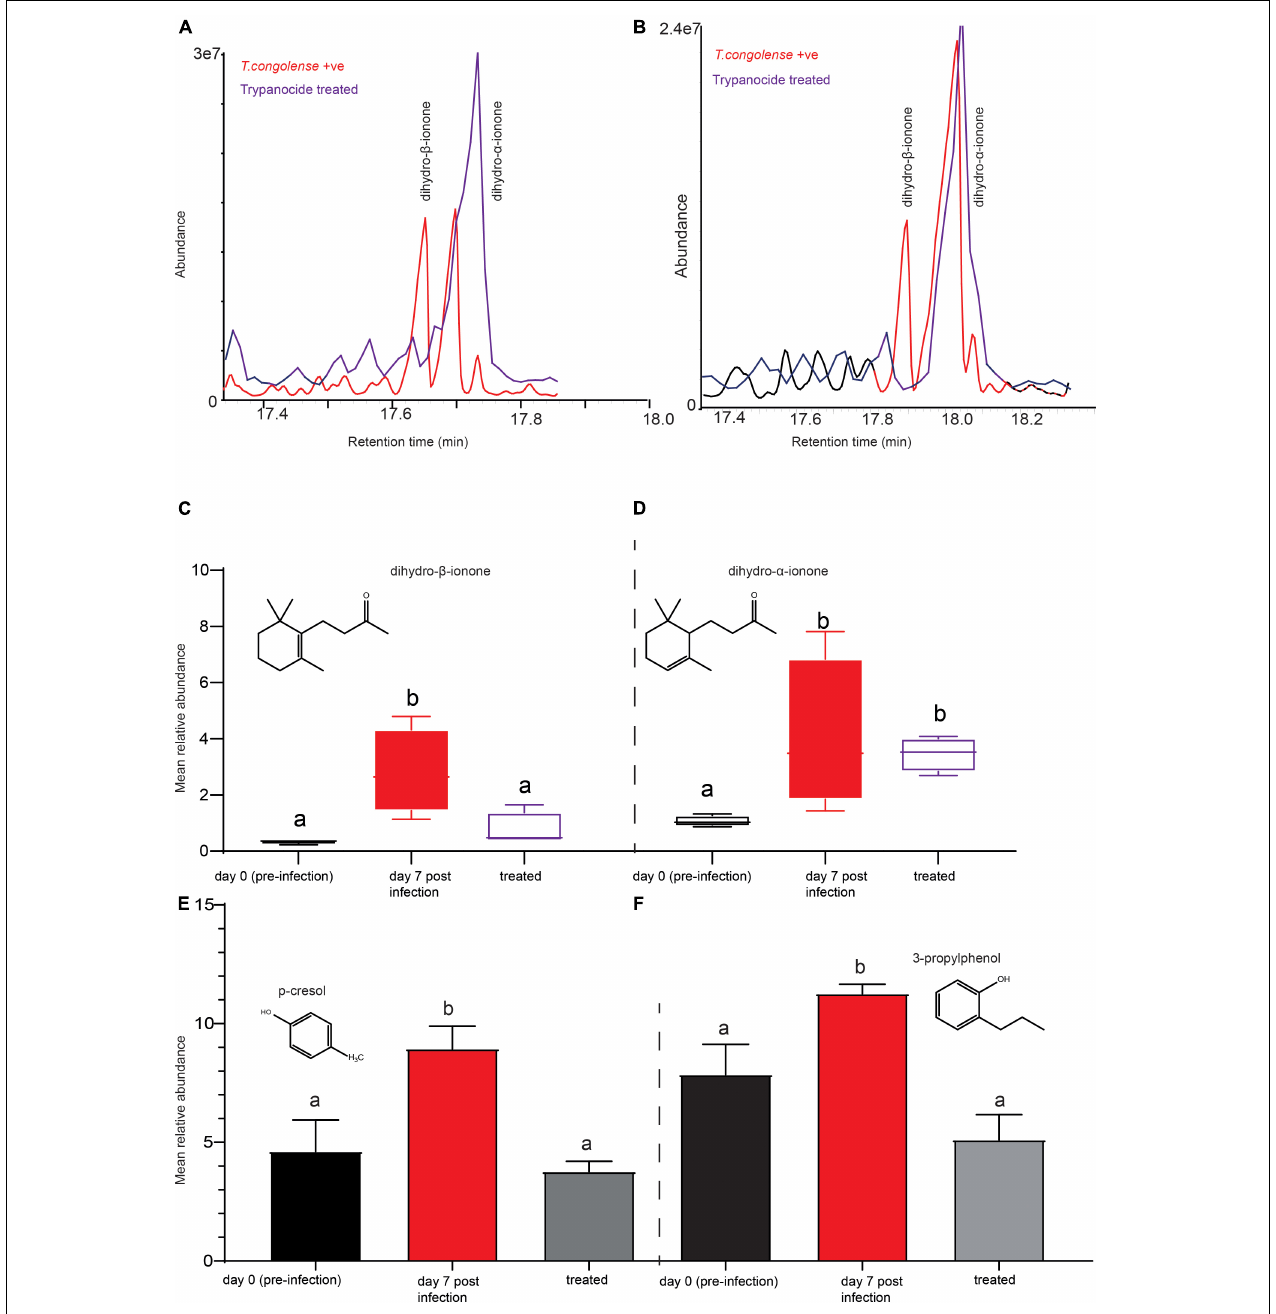
FIGURE 8 | Trypanocides treatment restored the metabolites back to normal. (A,B) Representaive GC-MS profiles showing key biomarker levels in trypanosome-infected (red) and after trypanocide treatment (purple). (C) The mean relative abundance of dihydro- β -ionone (D) dihydro- α -ionone at pre-infection, day 7 post-infection and after treatment. (E) The mean relative intensity of p -cresol and (F) 3-propylphenol at pre-infection, day 7 post-infection and after treatment. In (C–F) , bars followed by different letters are statistically significant. Error bars represent standard error of the mean.